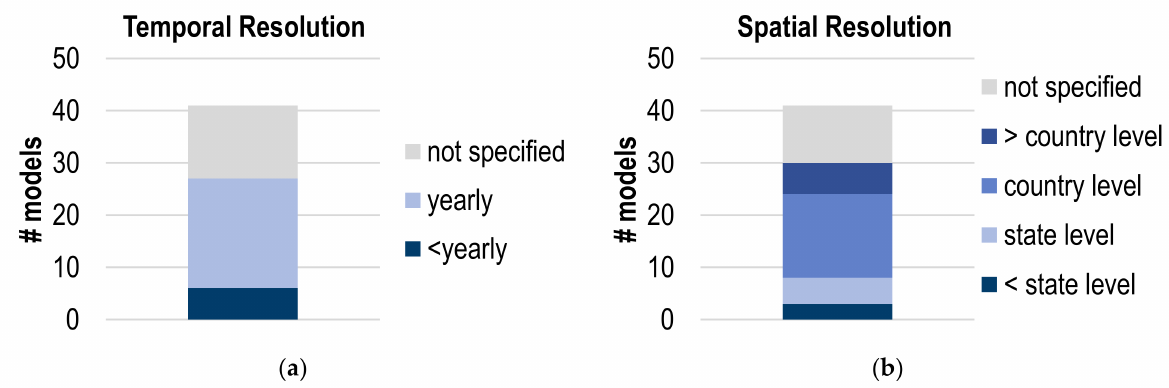
Figure A1. Temporal ( a ) and spatial ( b ) resolution of the investigated transport sector models. The analysis of the possible effects on energy infrastructures requires spatial